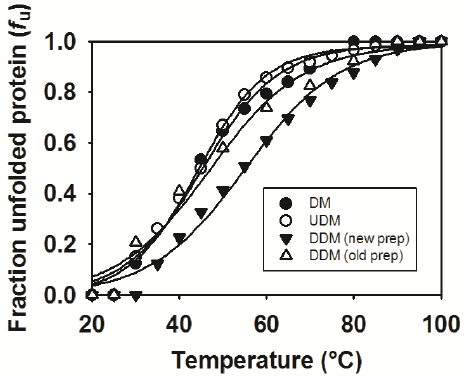
Figure 6. Thermal stability of MdtM in three different detergents represented as fraction of MdtM unfolded as a function of temperature. MdtM purified in DDM using the unmodified protocol is represented by open triangles. MdtM purified in DDM using the modified protocol is represented by filled inverted triangles. MdtM in UDM and MdtM in DM are represented by open and filled circles, respectively. Data points represent the mean of three individual